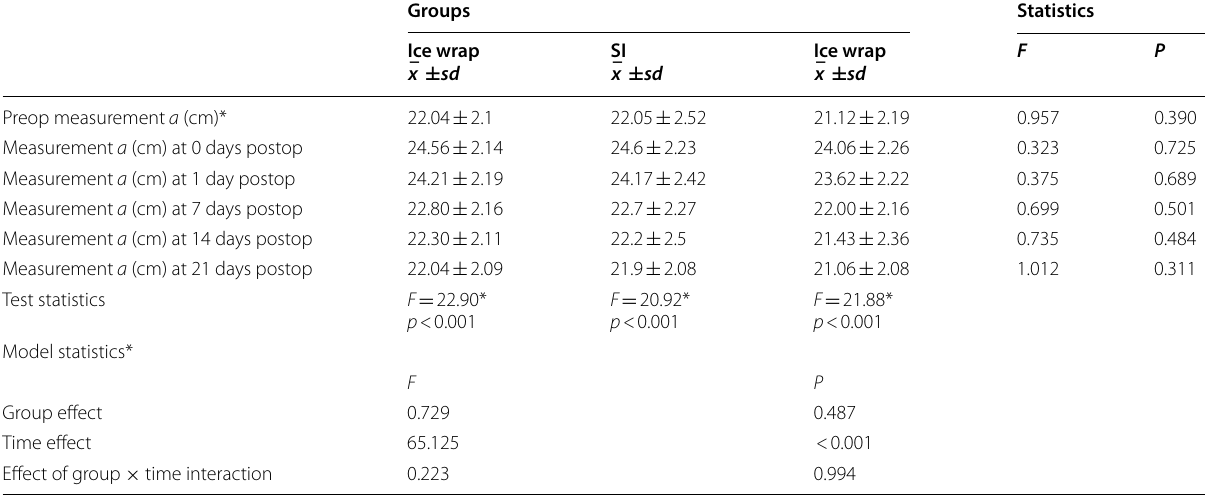
*Two-way repeated-measures variance analysis; a , b , c are results of inline multiple comparison test with Bonferroni correction